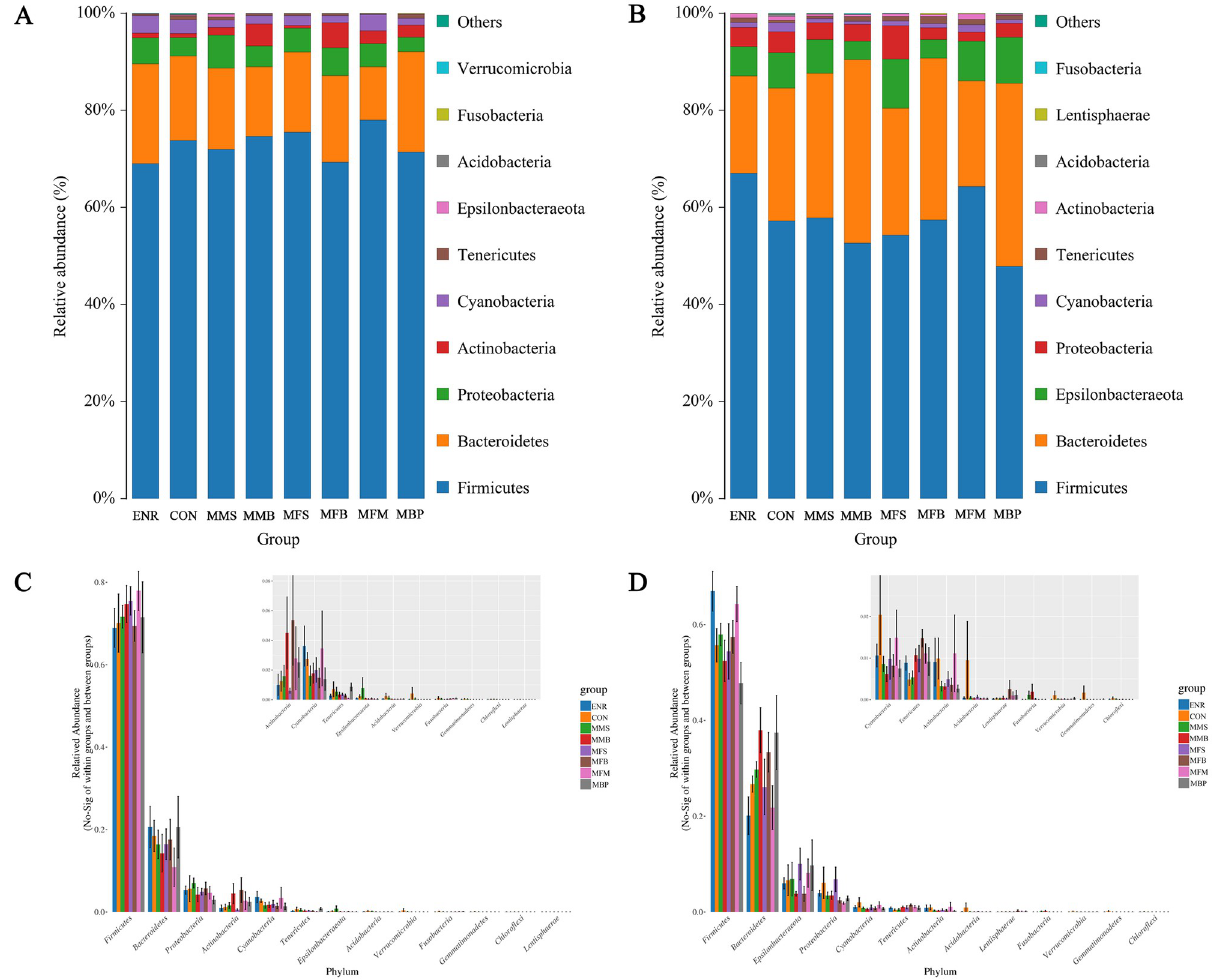
Fig 5. Different taxa and significantly different taxa between different groups by Anova analysis at the phylum level at 21 and 42 days old. (A) and (C) 21d. (B) and (D) 42d. CON, control diet; ENR; CON + 100 mg/kg ENR, MMS; CON + 2000 mg/kg MOS + 300 mg/kg MAN + 1500 mg/kg